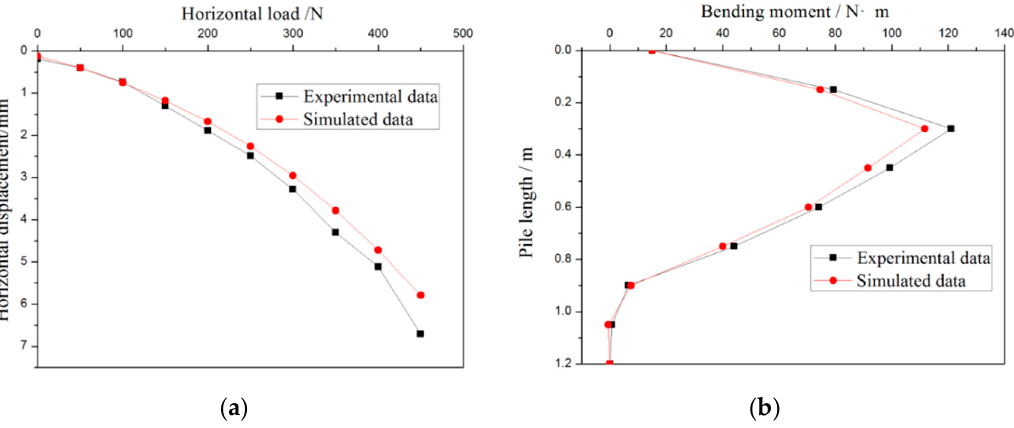
Figure 6. Comparison of test results and our finite element calculated values of the pile under various load: ( a ) load–displacement; ( b ) bending